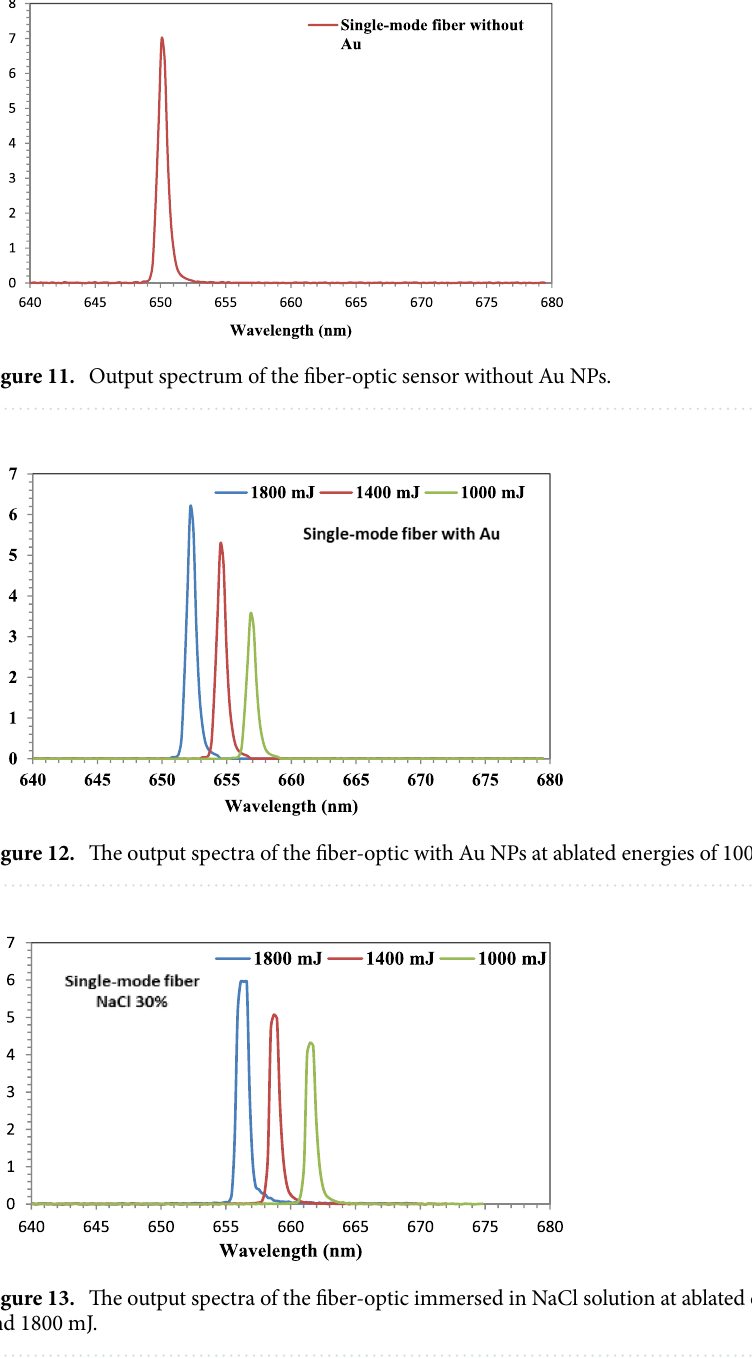
Figure 14 represents the output spectra of an unclad fiber-optic that was immersed in a 30% sucrose solu- tion. A blue shift in wavelength was observed as the laser ablation energies increased from 1000 to 1400 mJ and 1800 mJ. The shift was from 661 nm at 1000 mJ to 658 nm and to 654 nm at 1400 and 1800 mJ, respectively. The highest intensity was obtained at 1800 mJ with value of 6.04dBm. For the three spectra of the three ablated energies, a flat-top with 1 nm appeared. This is due to the uniform distribution of the Au NPs, which results in a high attachment to the sensing medium and an increase in sensitivity. Figure 15 represents the output spectra of an unclad fiber-optic immersed in a 30% concentration Glycerol solution. The graph depicts a red shift at ablated energies of 1000 mJ from650 to 661 nm. But, as the ablated energy increased to 1400 and 1800 mJ, a blue shift was taken place where the shift was to 657 nm and to 654 nm, respectively. The highest intensity was obtained at 1800 mJ with value of 6.11dBm.